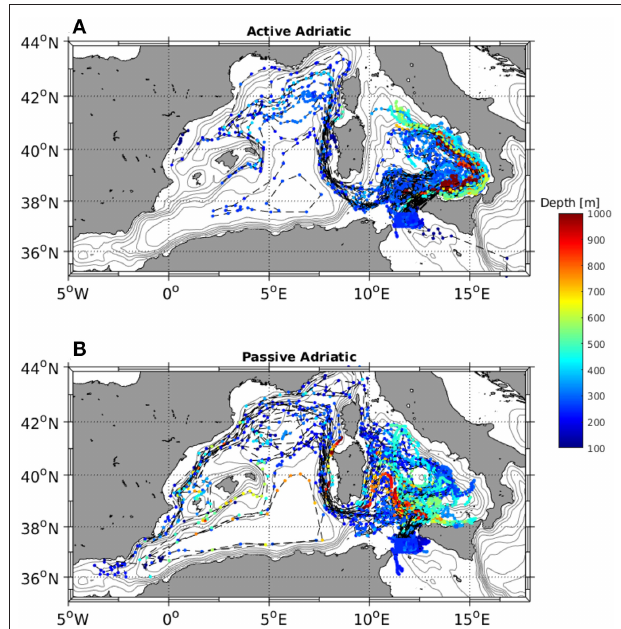
FIGURE 3 | 3D Lagrangian trajectories of 132 water particles released in the Sicily Strait at a depth of 250 m in two successive model years. The water particles were tracked for 3 years in an active Adriatic state (A) and a passive Adriatic state (B) . The colorbar indicates the depth of the particles at the given time. f / h contours are plotted in